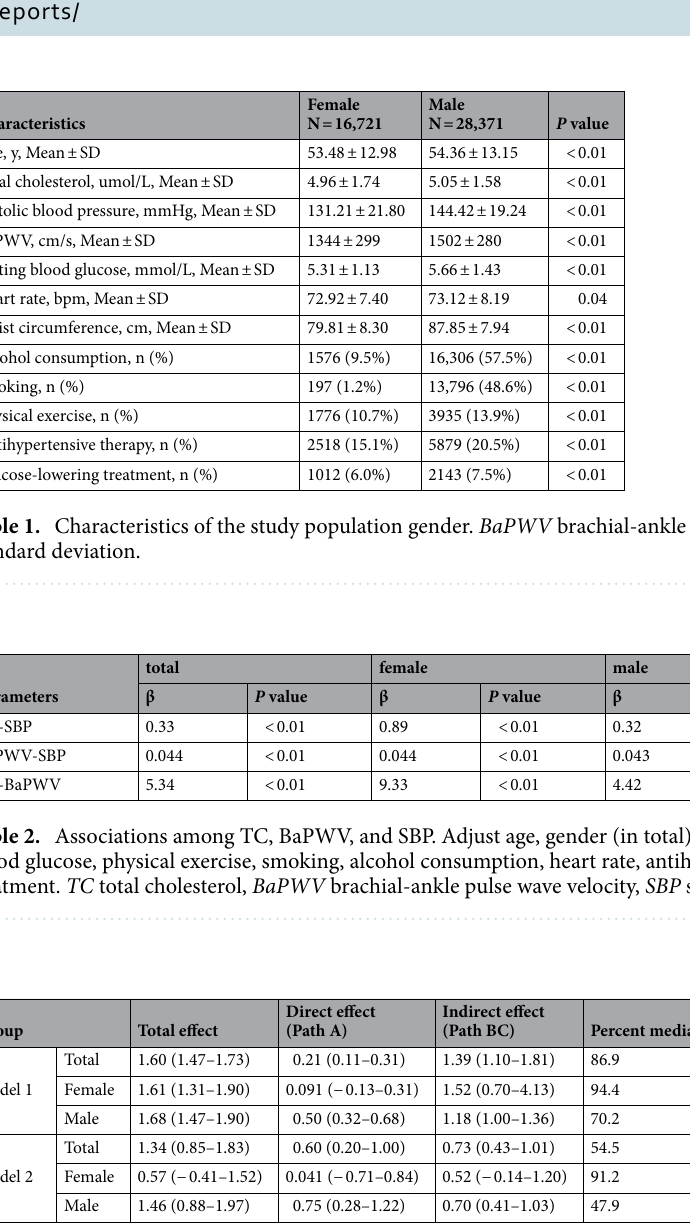
Table 3. Mediation effect of BaPWV in the association between TC levels and